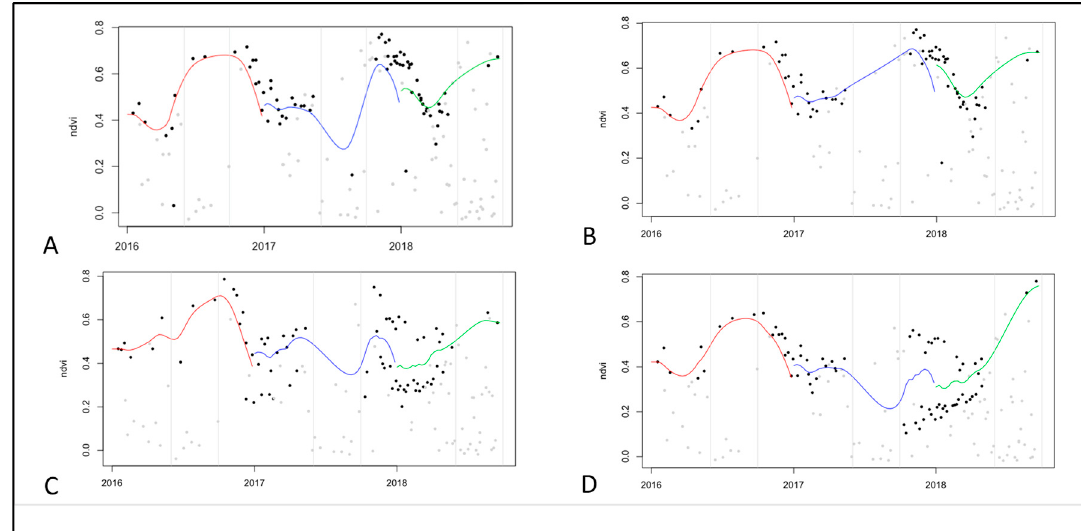
Figure 3. Example optical timeseries processing chains colored by year. Points show raw NDVI values colored gray if classified as cloud in first QAQC processing pass and black if not. A and B are for the same pixel. B is the result after removing additional cloud scenes with 2nd QAQC routine demonstrating the sensitivity of the preprocessing methods when few quality scenes are observed. C and D are different pixel examples showing how interpolation and smoothing is challenging during key growth stages. Both show a failure of the cloud masks late 2017 into early 2018.